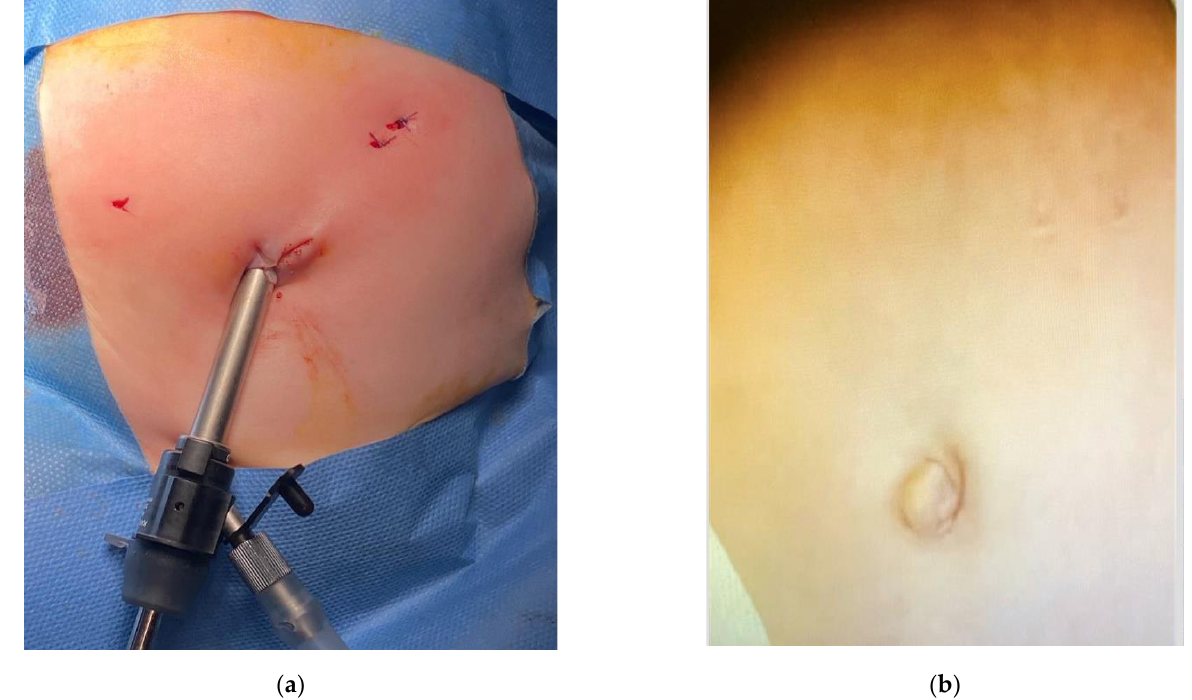
Figure 6. ( a ) Intraoperative image: end of the procedure, aspect of the extracorporeal suturing. ( b ) same patient attending follow-up clinic, cosmetic